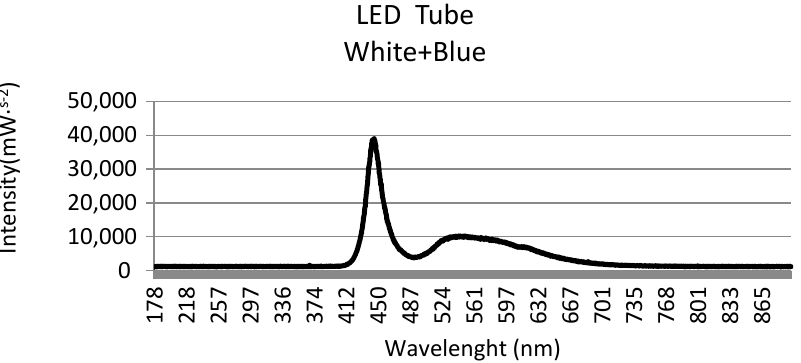
Figure 4. Spectral characteristic of white + blue light.